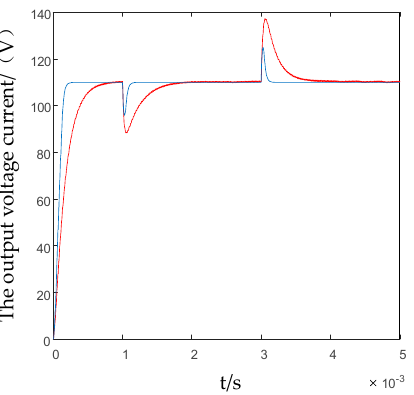
Figure 11. Simulation plot of the output voltage under two successive load changes.